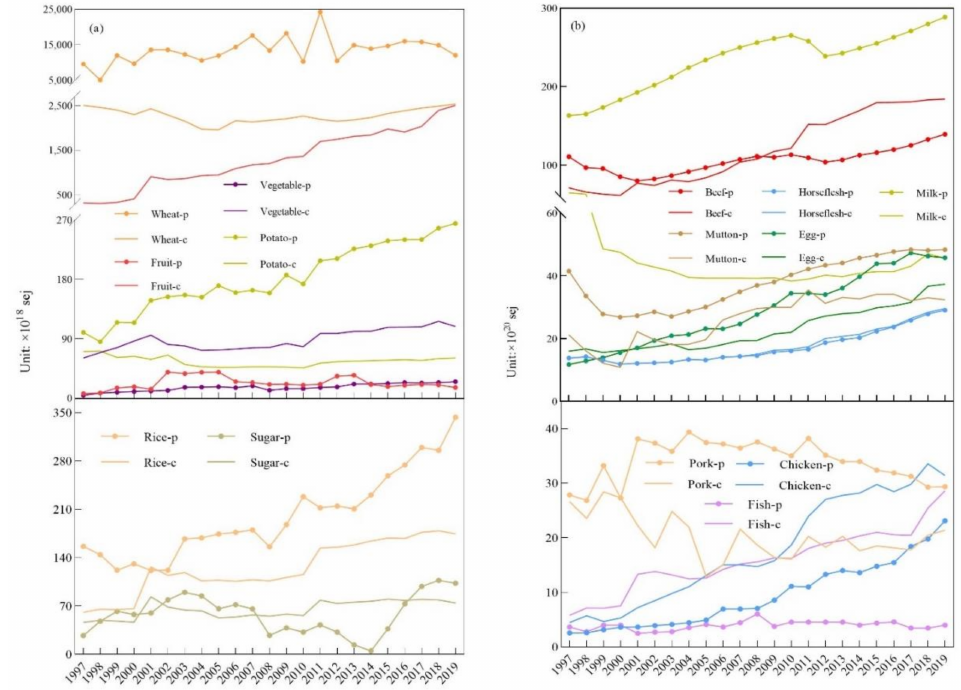
Figure 4. Annual food production and consumption in Kazakhstan. ( a ) Annual plant-based food pro- duction and consumption in Kazakhstan; ( b ) annual animal-based food production and consumption in Kazakhstan (-c represents consumption and -p represents